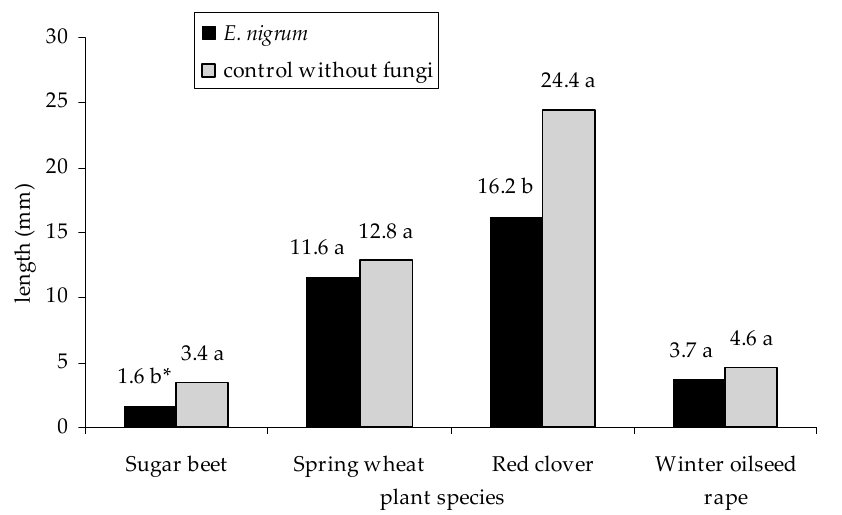
Figure 9. Effect of 18 strains of E. nigrum on the growth of seedlings of sugar beet ( B. vulgaris L. ssp. vulgaris ), spring wheat ( T. aestivum L.), red clover ( T. pratense L.), and winter oilseed rape ( B. napus L.). Means followed by the same letter (*) are not statistically different at the α ≤ 0.01 level, according to the Tukey HSD test. Letters indicate the differences in the interaction between E. nigrum strains and the control group due to the length of a given seedling.